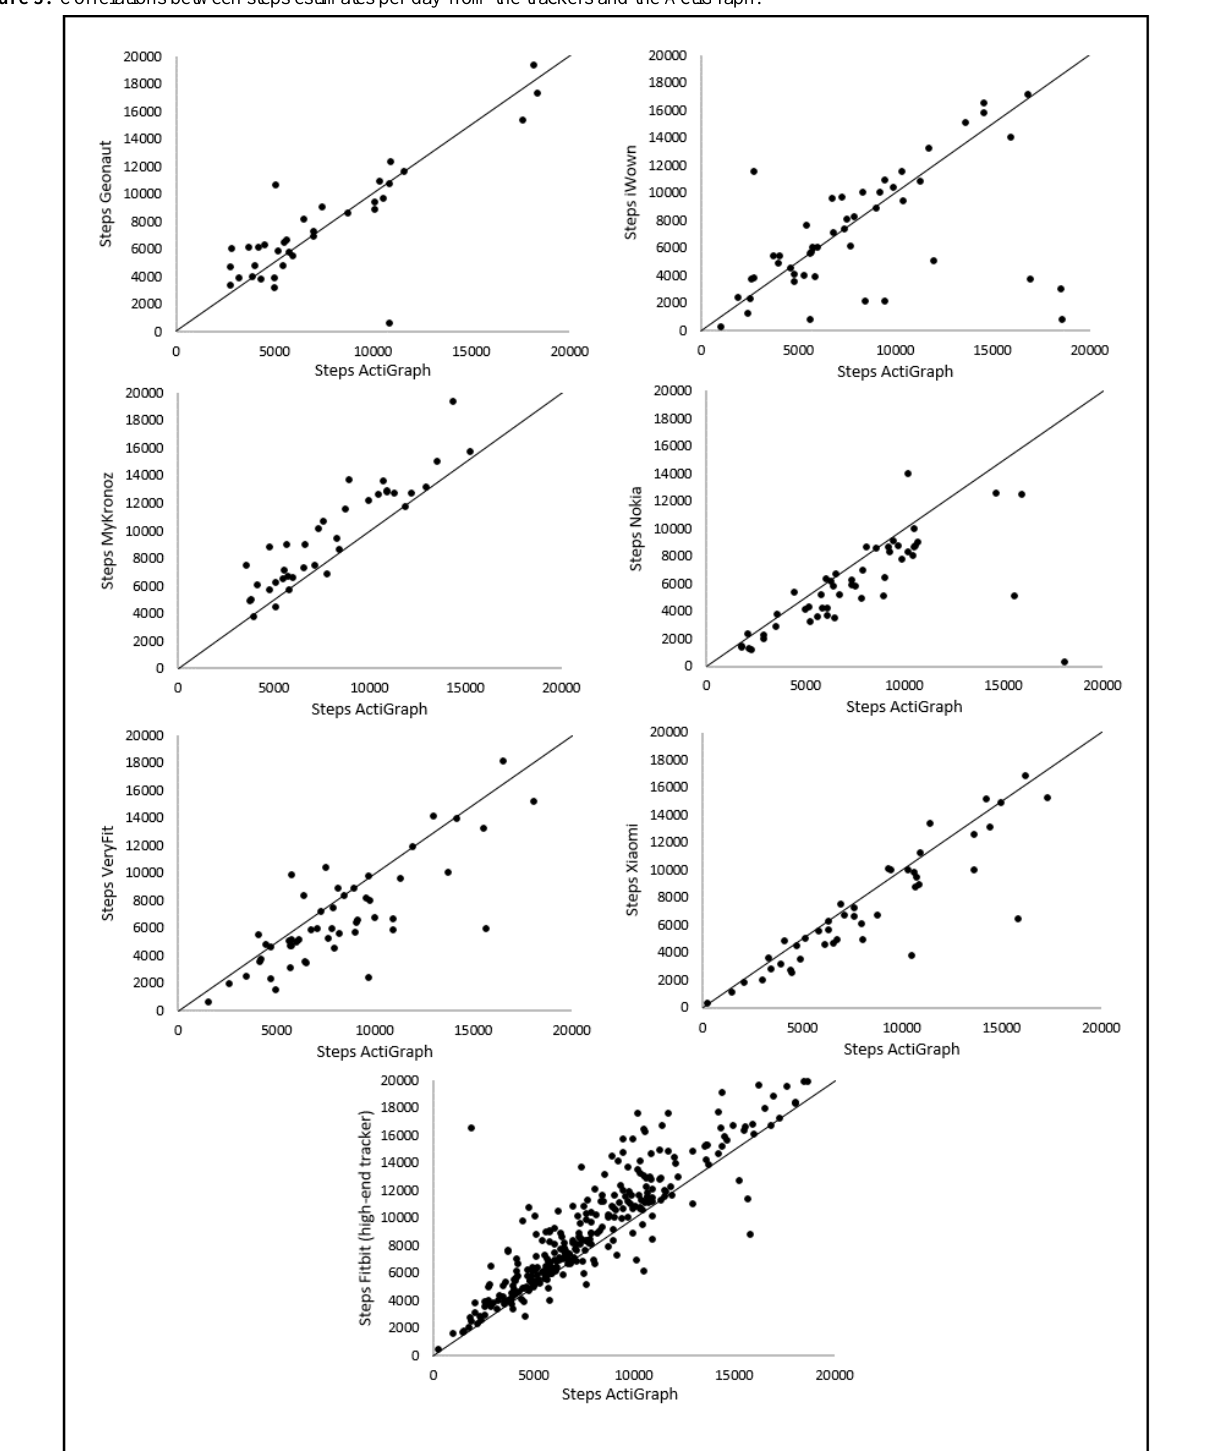
Figure 3. Correlations between steps estimates per day from the trackers and the